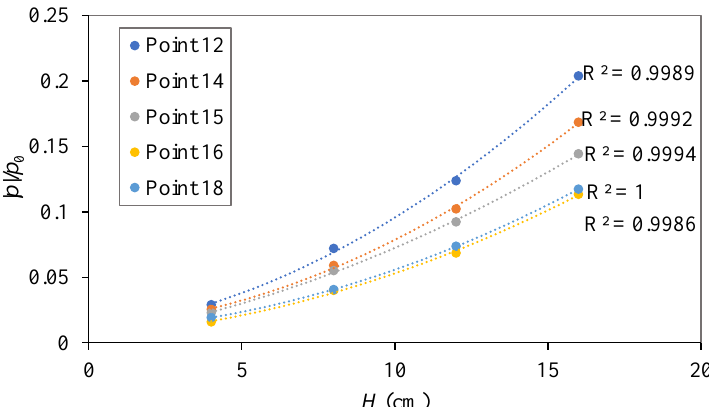
Figure 16. Fitting curve of the relationship between pore pressure and wave height at different points around the pile.